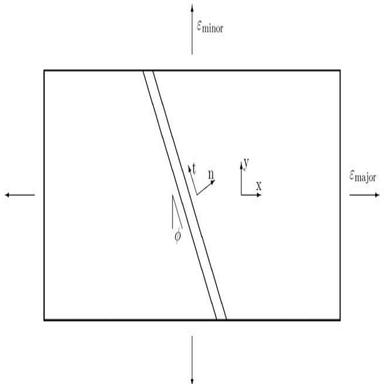
Schematic of the MK model showing an imperfection band deforming under general biaxial stretching.